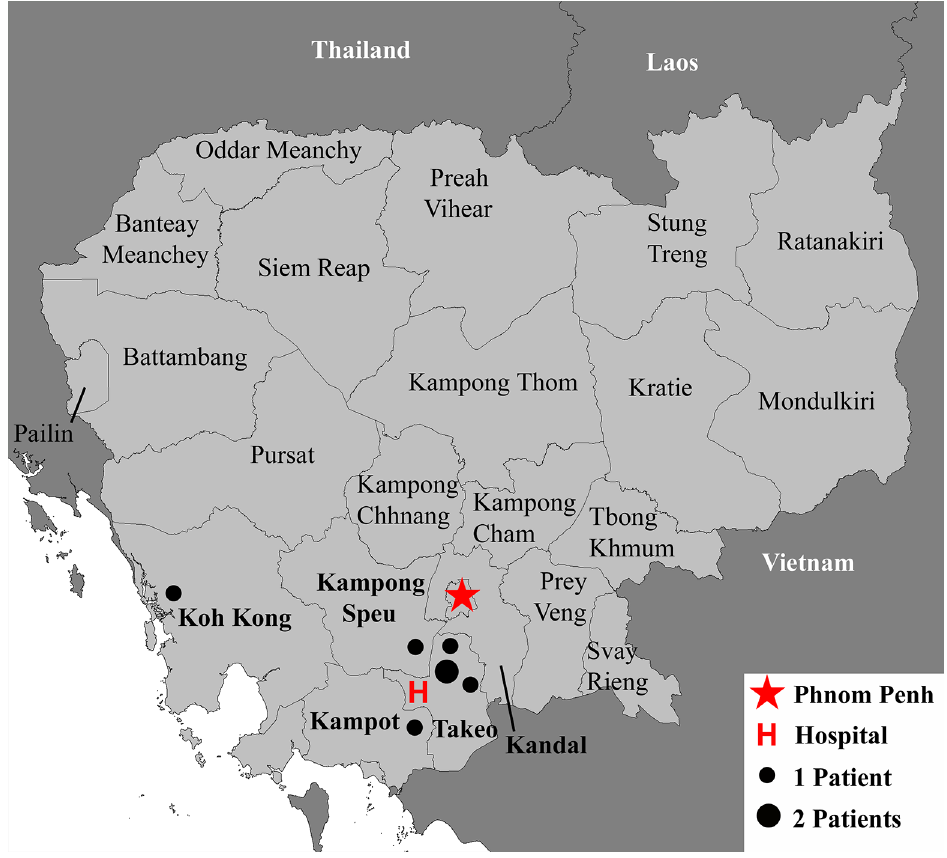
Fig 1. Study site. We used DIVA-GIS (http://diva-gis.org/) to create a map of Cambodiaand surrounding areas. The red H indicatesTakeo ProvincialHospital, the study site for this work. Dots indicate the locationof the home villageof seven melioidosis patients. Map is reflective of CambodianProvincial borders duringthe time of patient enrollment.